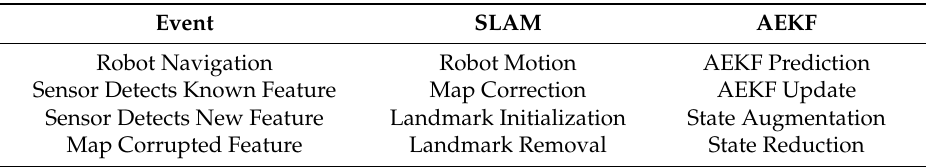
Table 3. The AEKF operations for achieving underwater SLAM.